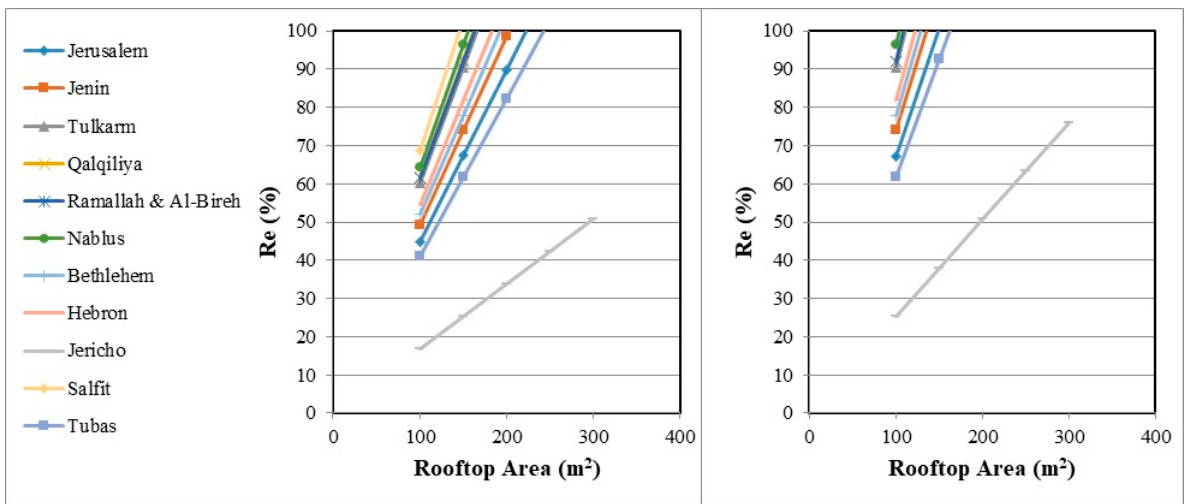
Figure 7. Re percentages of different West Bank governorates for the different rooftop areas for a monthly DWDv of 6.5 m 3 /family. S1 ( left ); S2 ( right ).